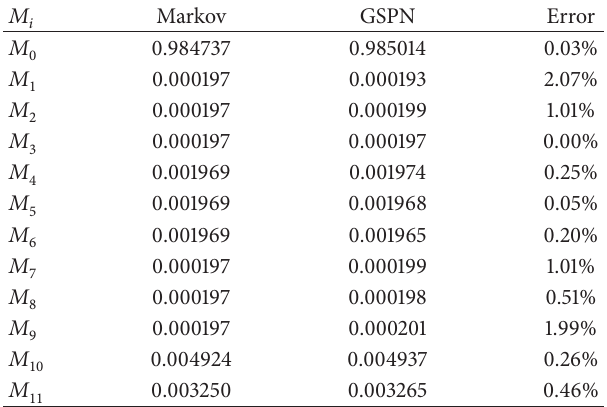
Table 3: The errors of steady state probability between methods of Markov and GSPN.